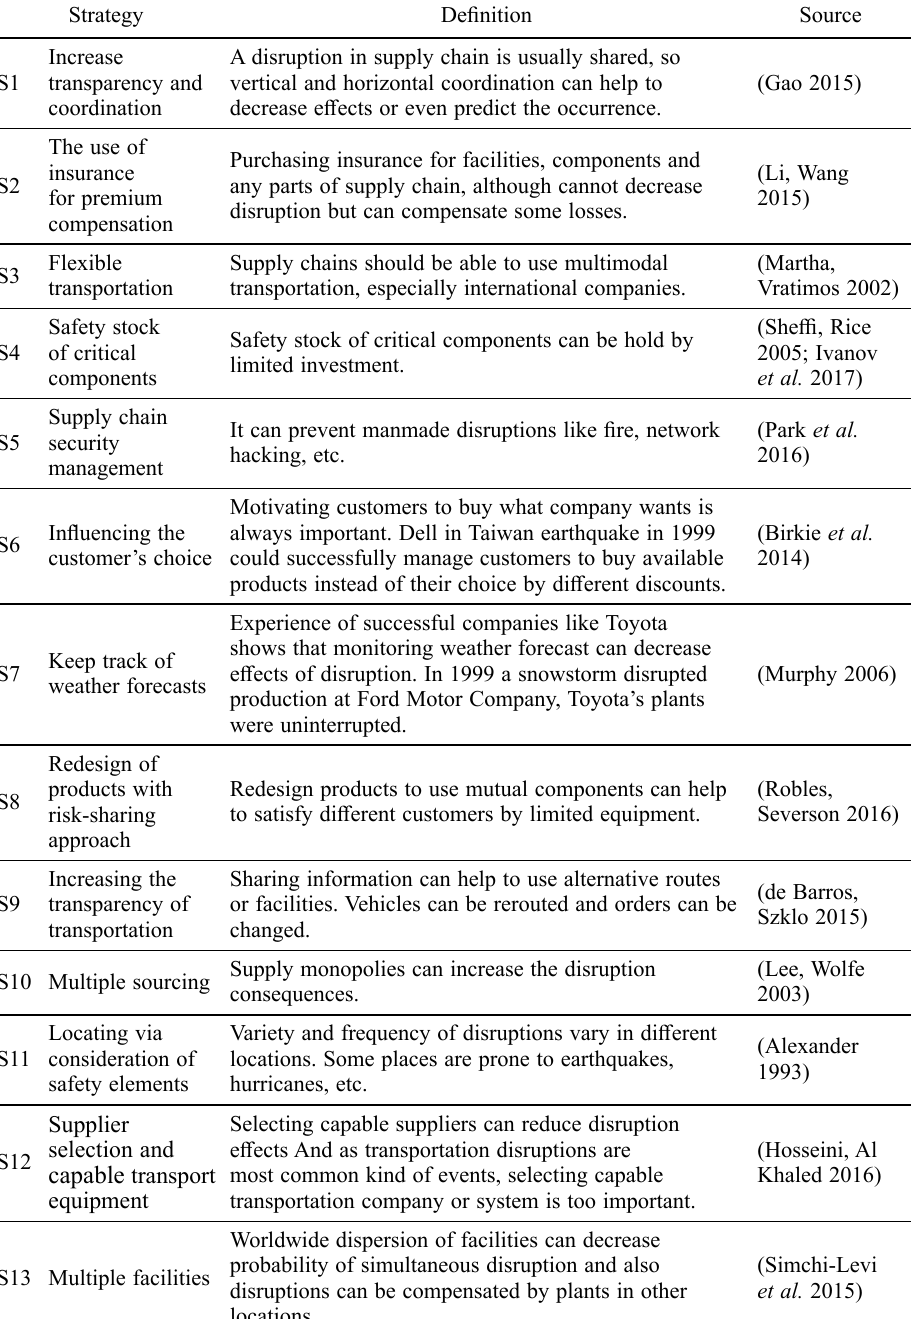
Table 5. Brief definition of each